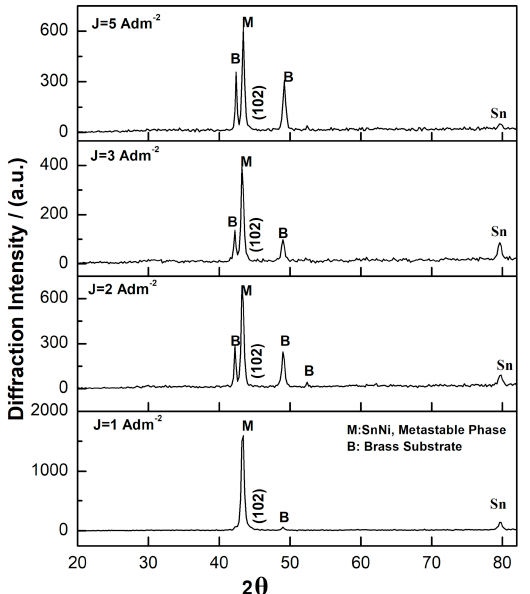
Figure 3. X-Ray diffraction patterns of pure Sn–Ni coatings produced under direct current (DC) Figure 3. X-Ray di ff raction patterns of pure Sn–Ni coatings produced under direct current (DC) conditions and various applied current density values. conditions and various applied current density